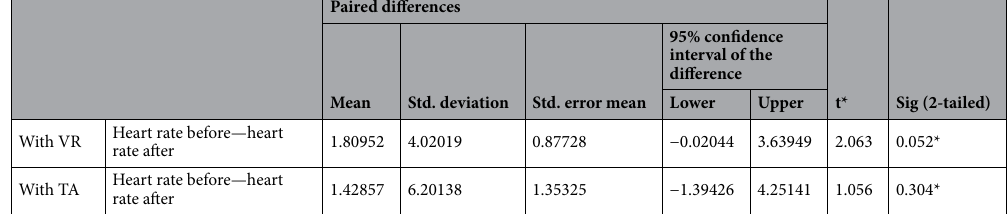
95% confidence interval of